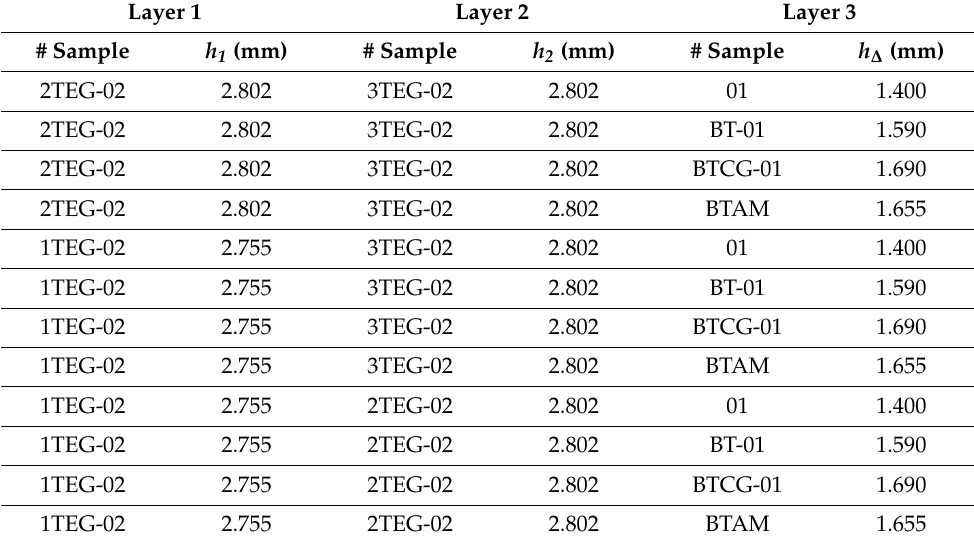
Table 19. Three-layer combinations of composites based on PVC-filled